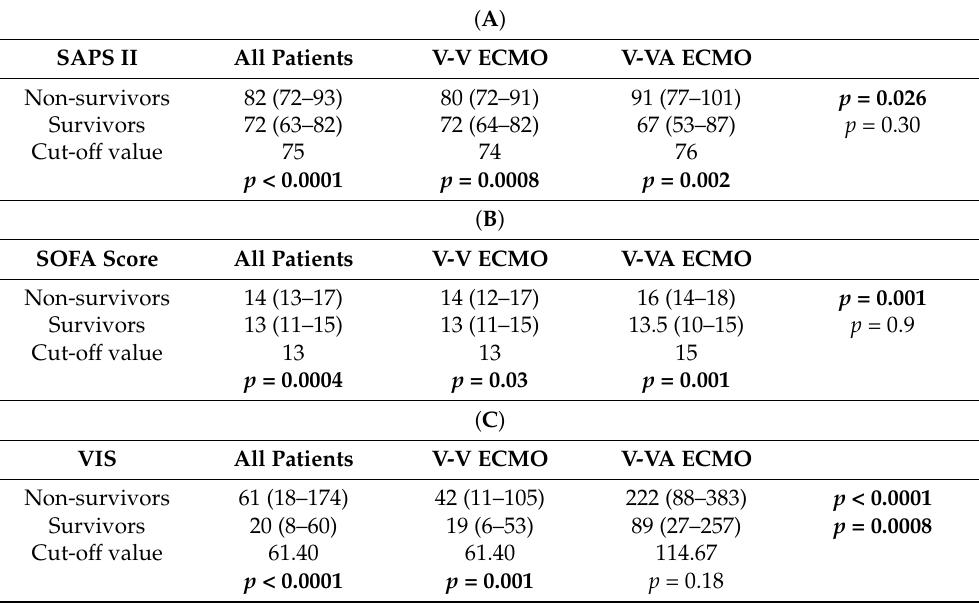
Table 2. ( A ) SAPS II within the first 24 h after ICU admission in all patients, non-survivors and survivors. ( B ) SOFA score within the first 24 h after ICU admission in all patients, non-survivors and survivors. ( C ) Pre-ECMO VIS in all patients, non-survivors and